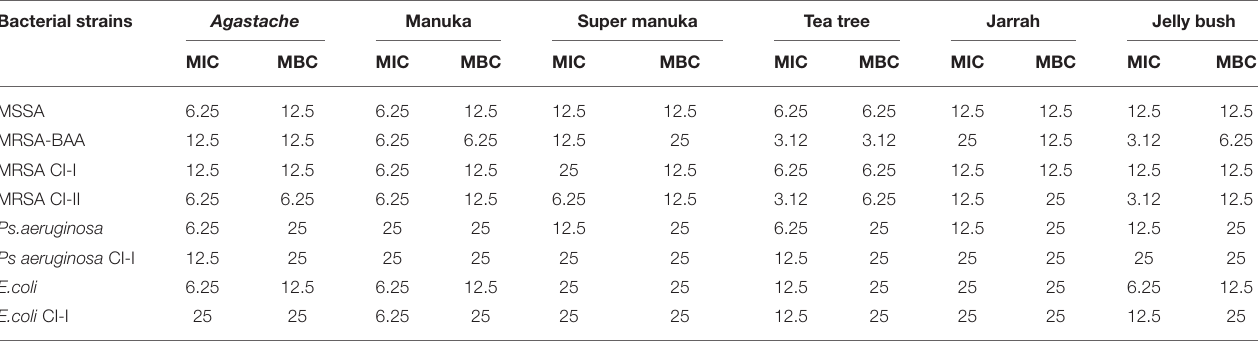
TABLE 2 | Minimum inhibitory concentration (MIC) and minimum bactericidal concentration (MBC) of honey (%) to inhibit 100% of the microbial growth in vitro expressed in % w/v solution ( n = 3). Bacterial strains Agastache Manuka Super manuka Tea